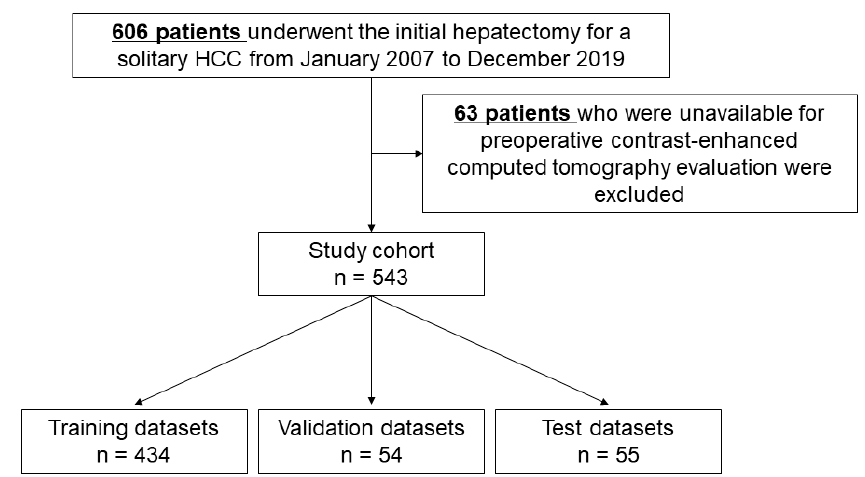
Figure 1. Flowchart of dataset selection.